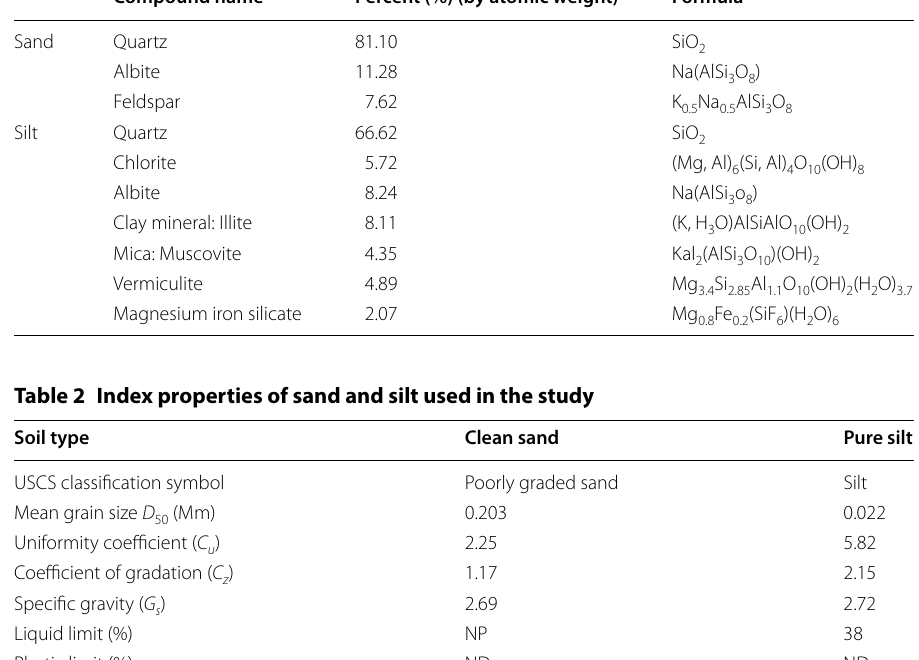
Table 1 Quantitative X-RD test result Compound name